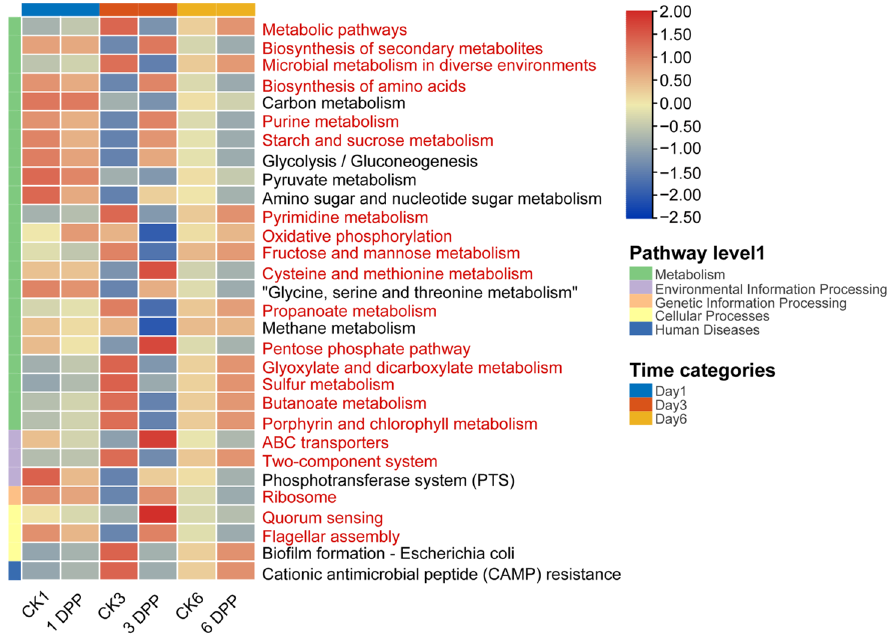
Figure 6. Relative abundance (%) of host-gut microbiota functions between parasitized and non- parasitized larvae at different time categories at the Kyoto Encyclopedia of Genes and Genomes (KEGG) level 3. The heatmap plot was normalized by row. The red letter indicates that the special function at KEGG pathway level 3 significantly differed from the control group during the parasitism ( p < 0.05). Group color bars on the left indicate that the functions were grouped according to pathway level 1.